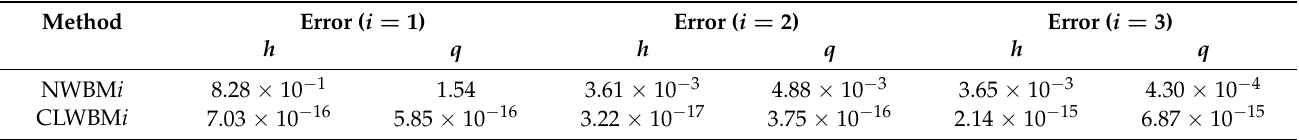
Figure 12. Test 4.3. Differences between the stationary and the numerical solutions at time t = 1 s with a 100-cell mesh. Table 16. Test 4.3. Differences in L 1 -norm with respect to the stationary solution for NWBM i and CLWBM i ( i = 1,2,3) for the 100-cell mesh at time t = 1